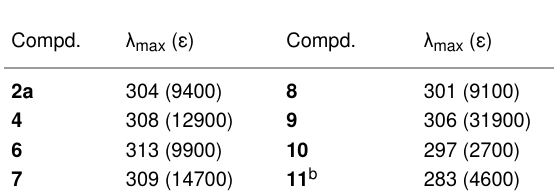
Table 2: Absorption spectroscopy data a